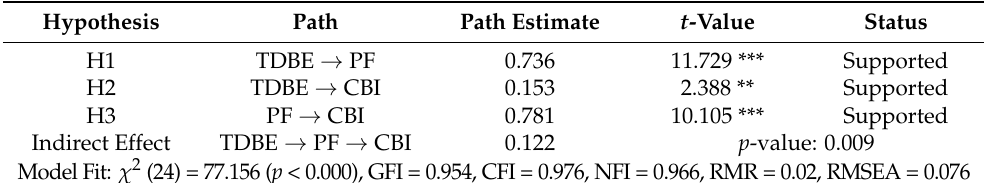
Table 4. Result of SEM.